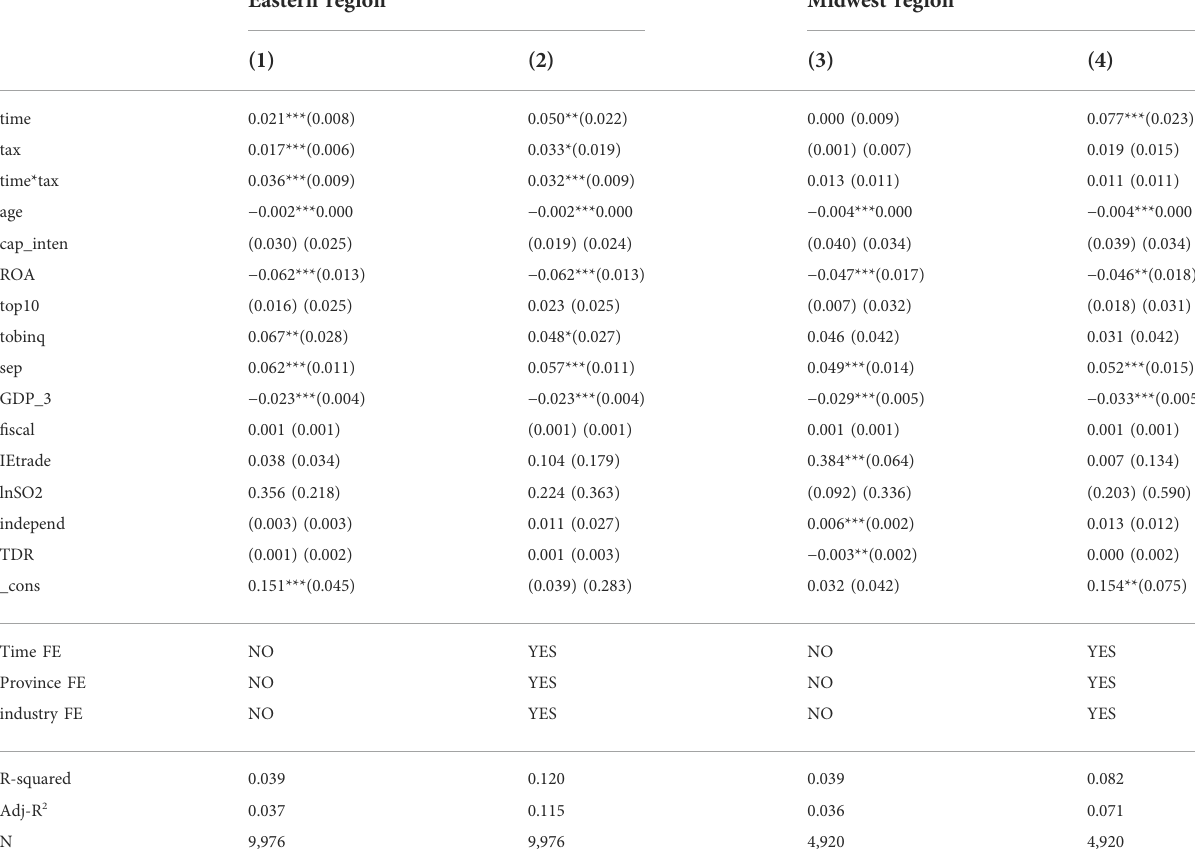
TABLE 11 Robustness test regression results: Regional